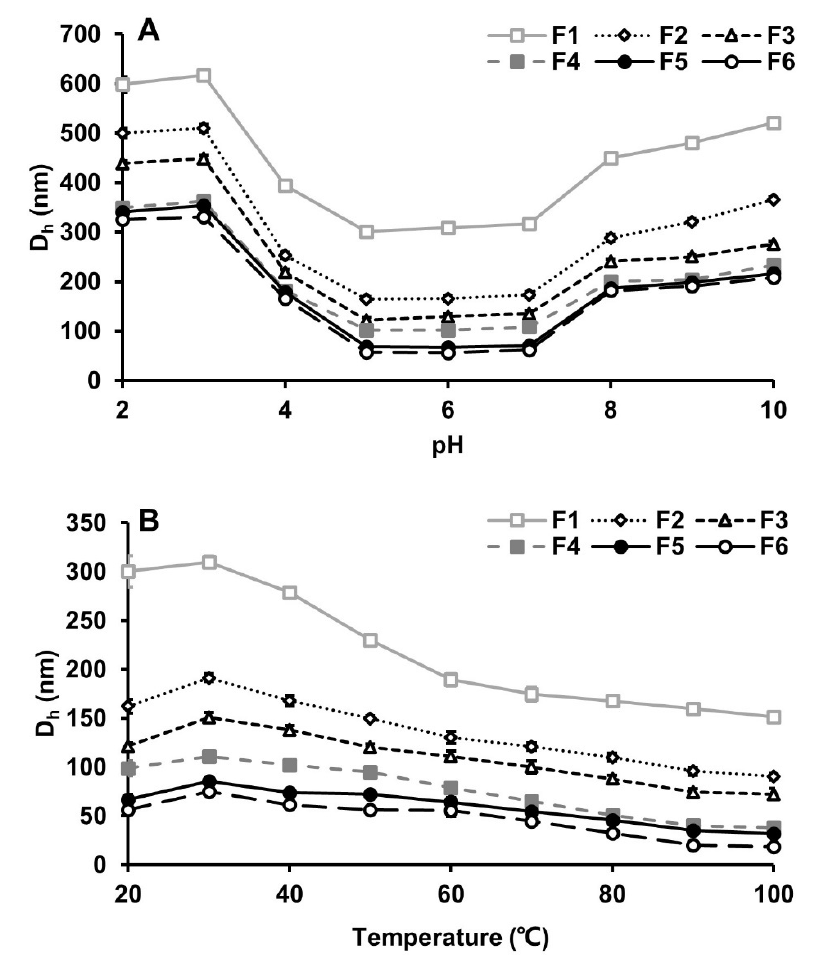
Figure 2. Influences of pH and temperature on BLG nanoparticles derived from BLG decoction. ( A ) The PH response of BLG nanoparticles fractions on the particle D h . ( B ) Temperature response of BLG nanoparticles fractions on the particle D h .